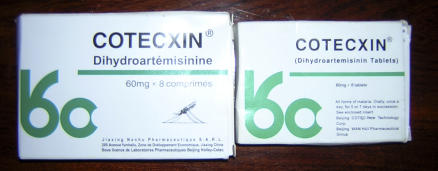
Genuine (Left) and Counterfeit (Right) Cotexcin (Dihydroartemisinin) from Tanzania (Photograph by Manuela Sunjio)